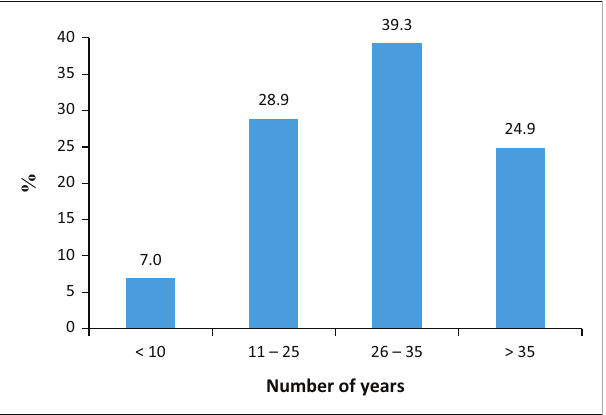
FIG URE 1: Number of years one lived in Okhahlamba municipal